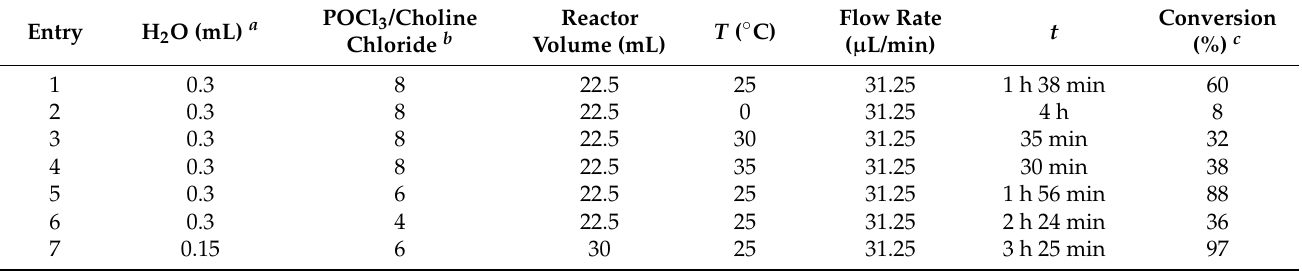
Table 2. Reaction conditions and conversions of first reaction step in a flow